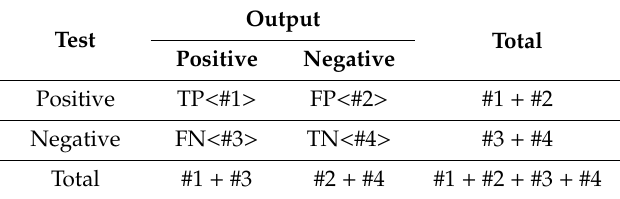
Table 1. Number of output and test.